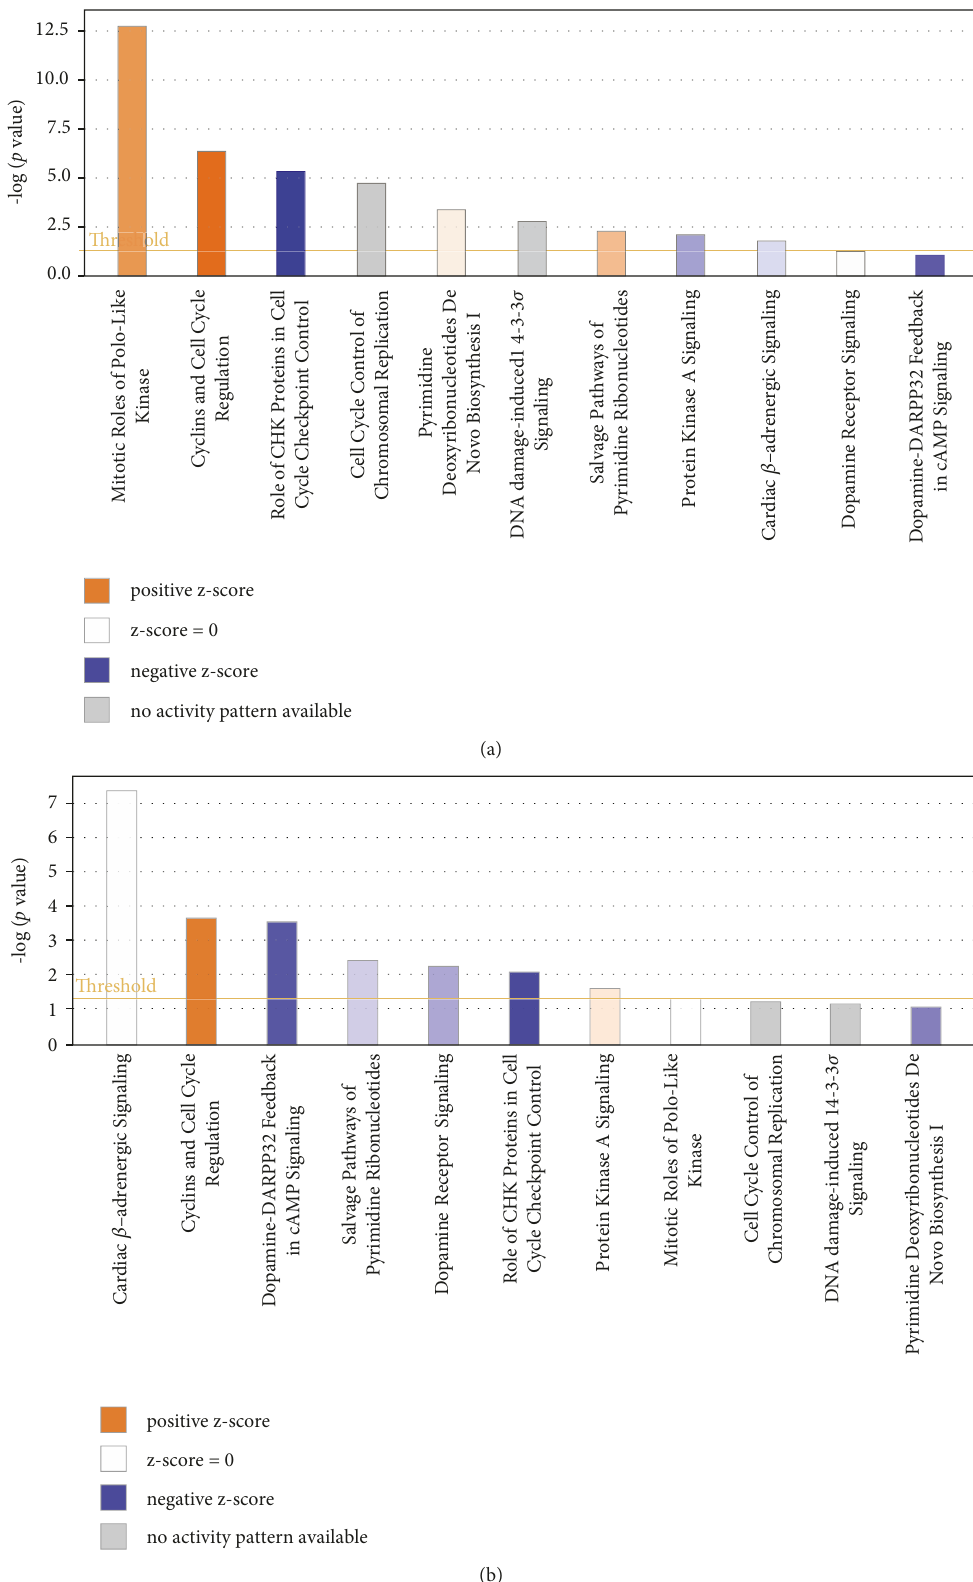
Figure 5: Ingenuity Canonical Analysis showing 11 pathways harboring the corresponding genes in the transcriptome analysis to differentiate malignant PC/PG in (a) TCGA and (b) COMETE cohort. PC: pheochromocytoma; PG: